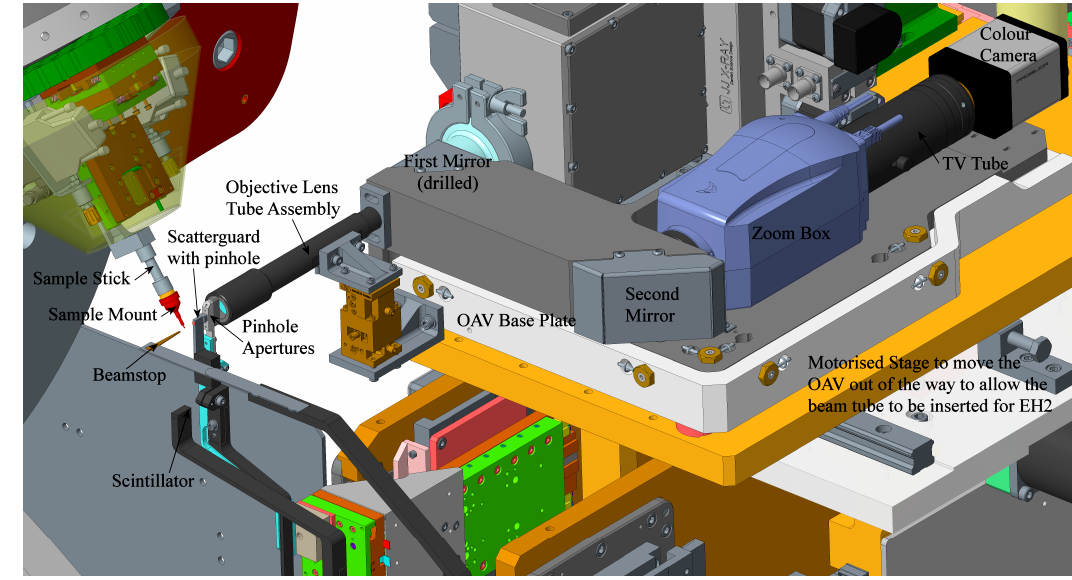
Figure 6. Detailed view of the on-axis viewer assembly and beam conditioning “sticks” located in the vicinity of the sample. The ω -axis is shown at 180°.